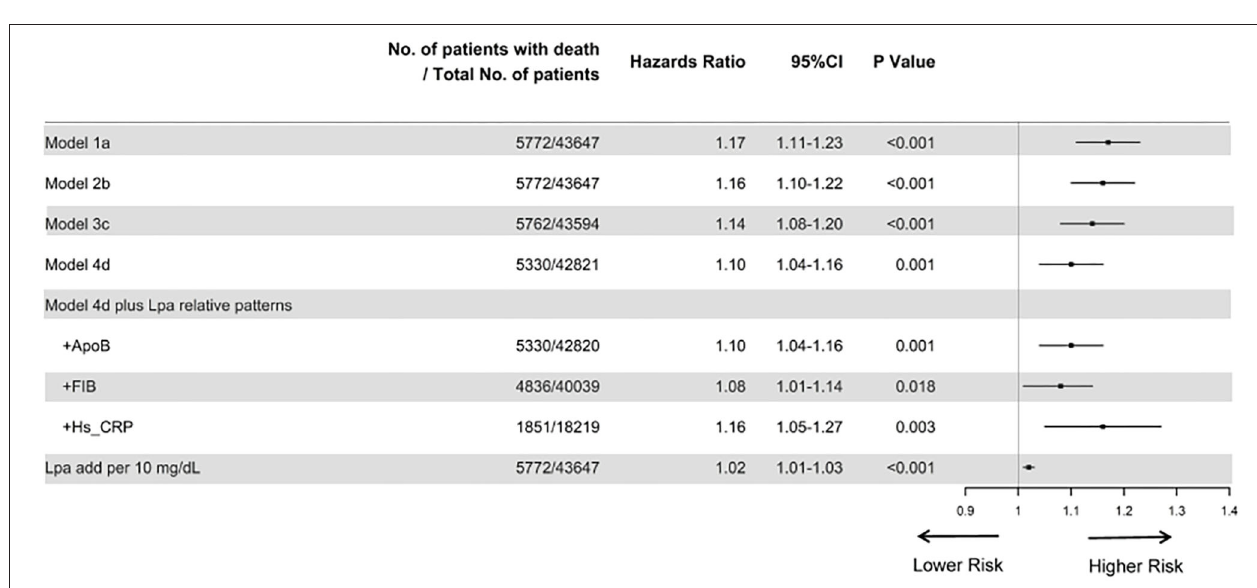
FIGURE 3 | Cox proportional hazard ratios for long-term all-cause mortality in different models. Model 1 was unadjusted; model 2 was only adjusted for age and gender; Model 3 was adjusted for age, gender, total cholesterol, triglycerides, apolipoprotein A and low-density lipoprotein cholesterol; and model 4 was adjusted for age, gender, hypertension, acute myocardial infraction, diabetes mellitus, percutaneous coronary intervention, hemoglobin, white blood cell, congestive heart failure, total cholesterol, triglyceride, apolipoprotein A, low-density lipoprotein cholesterol, high-density lipoprotein cholesterol, chronic kidney disease, angiotensin-converting enzyme inhibitor/angiotensin receptor blockers, β -blockers, and statins. Furthermore, we additionally adjusted apolipoprotein B, fibrinogen, and hypersensitive C-reactive protein, respectively, based on model 4. Finally, we unadjusted for lipoprotein(a) additionally per 10